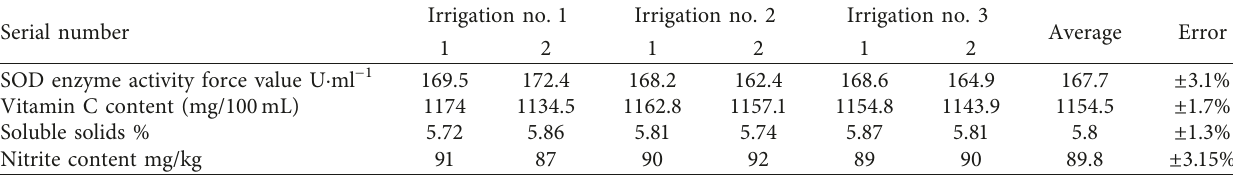
Table 12: Test results for SOD enzyme activity, vitamin C content, soluble solids content, and nitrite.